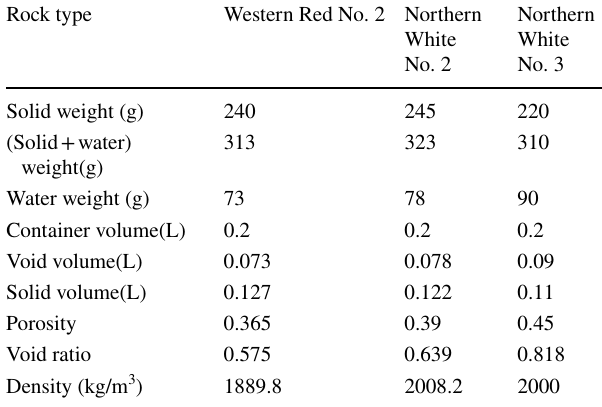
Table 1 Different sizes of roughing filter media as in Wegelin (1996) Roughing filter description